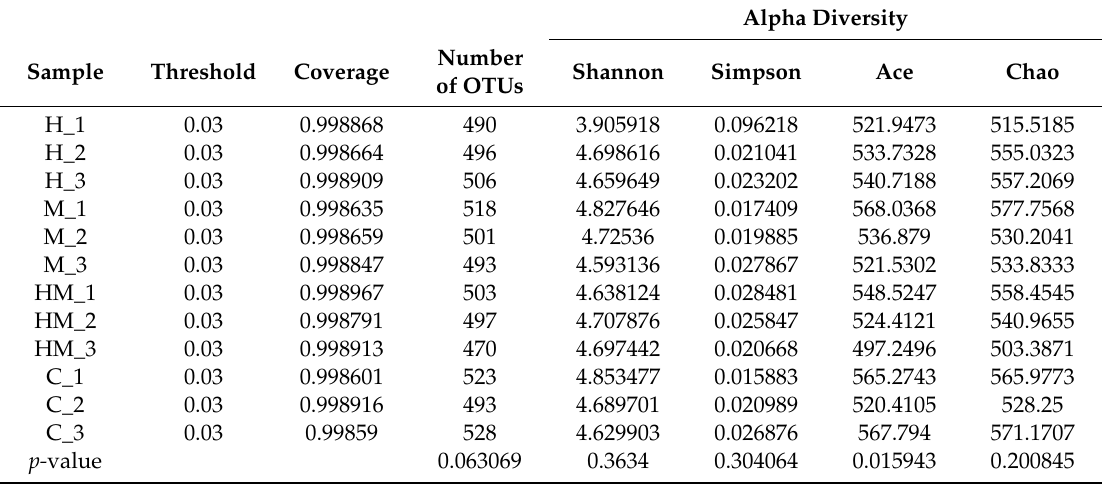
Table 3. Richness and diversity indexes relative to each gut sample (operational taxonomic unit (OTU) cut-o ff of